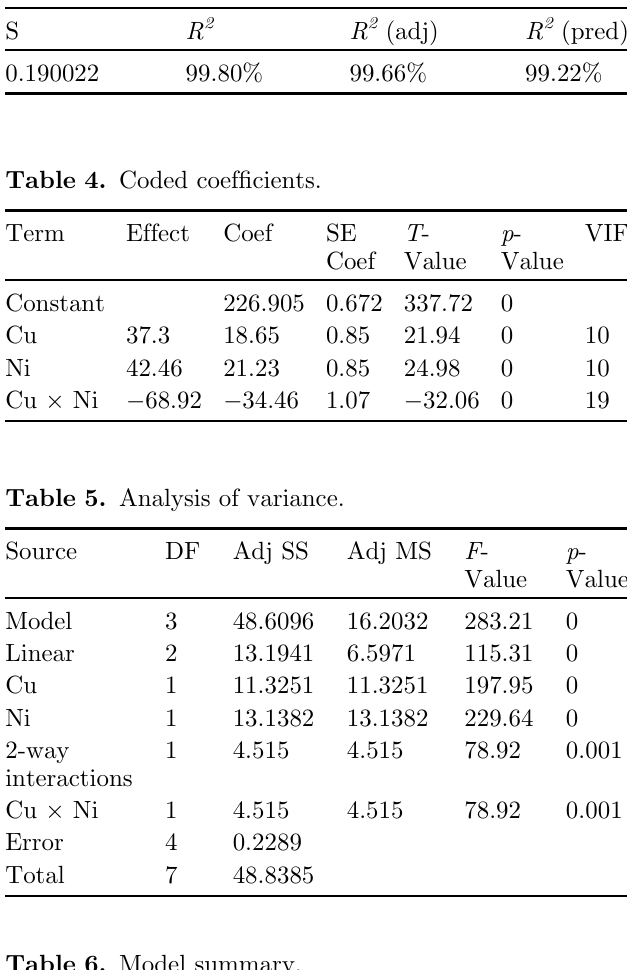
Table 3. Model summary.